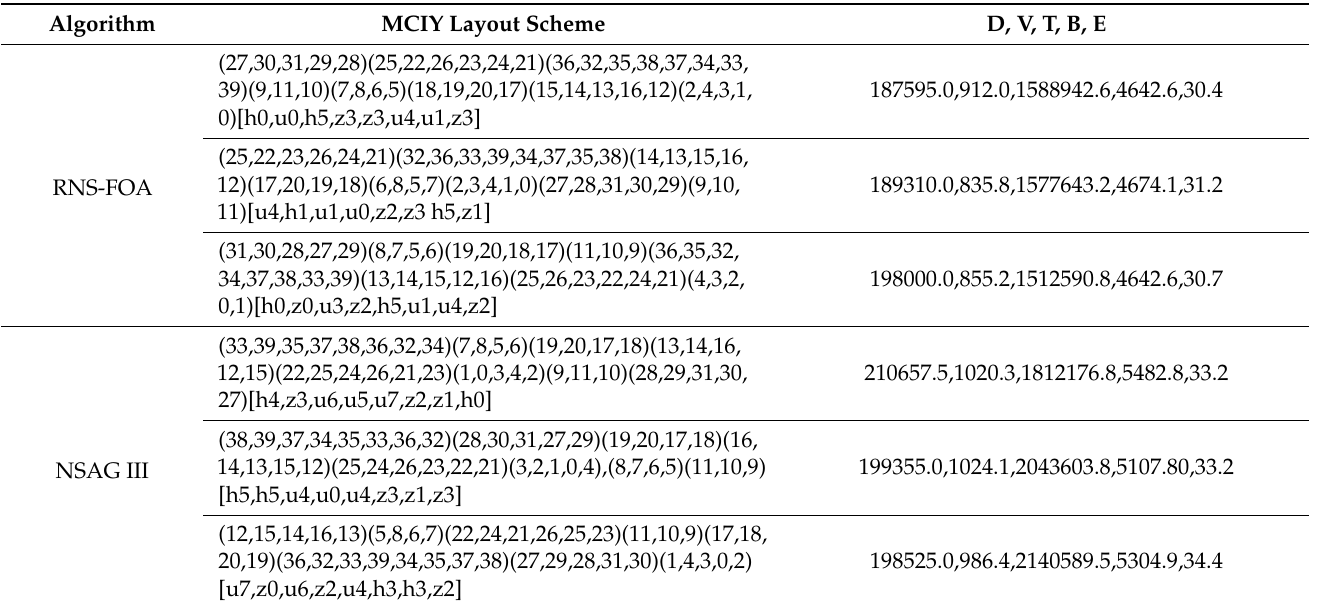
Table 4. Integrated layout example solution results.